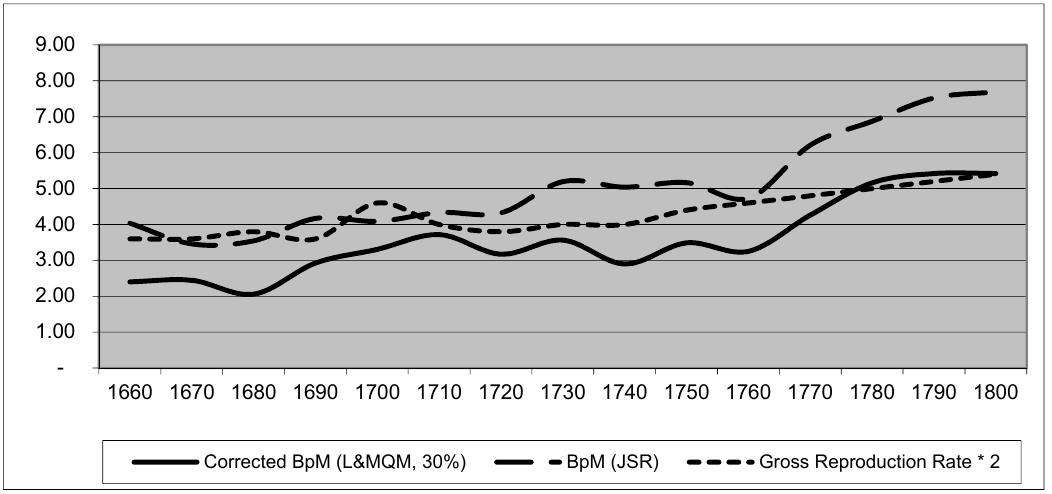
Figure 2. Comparison of births per marriage (BpM) for L&M QM and Rowntree, gross reproduction rate (GRR) (doubled) for comparison 23 .